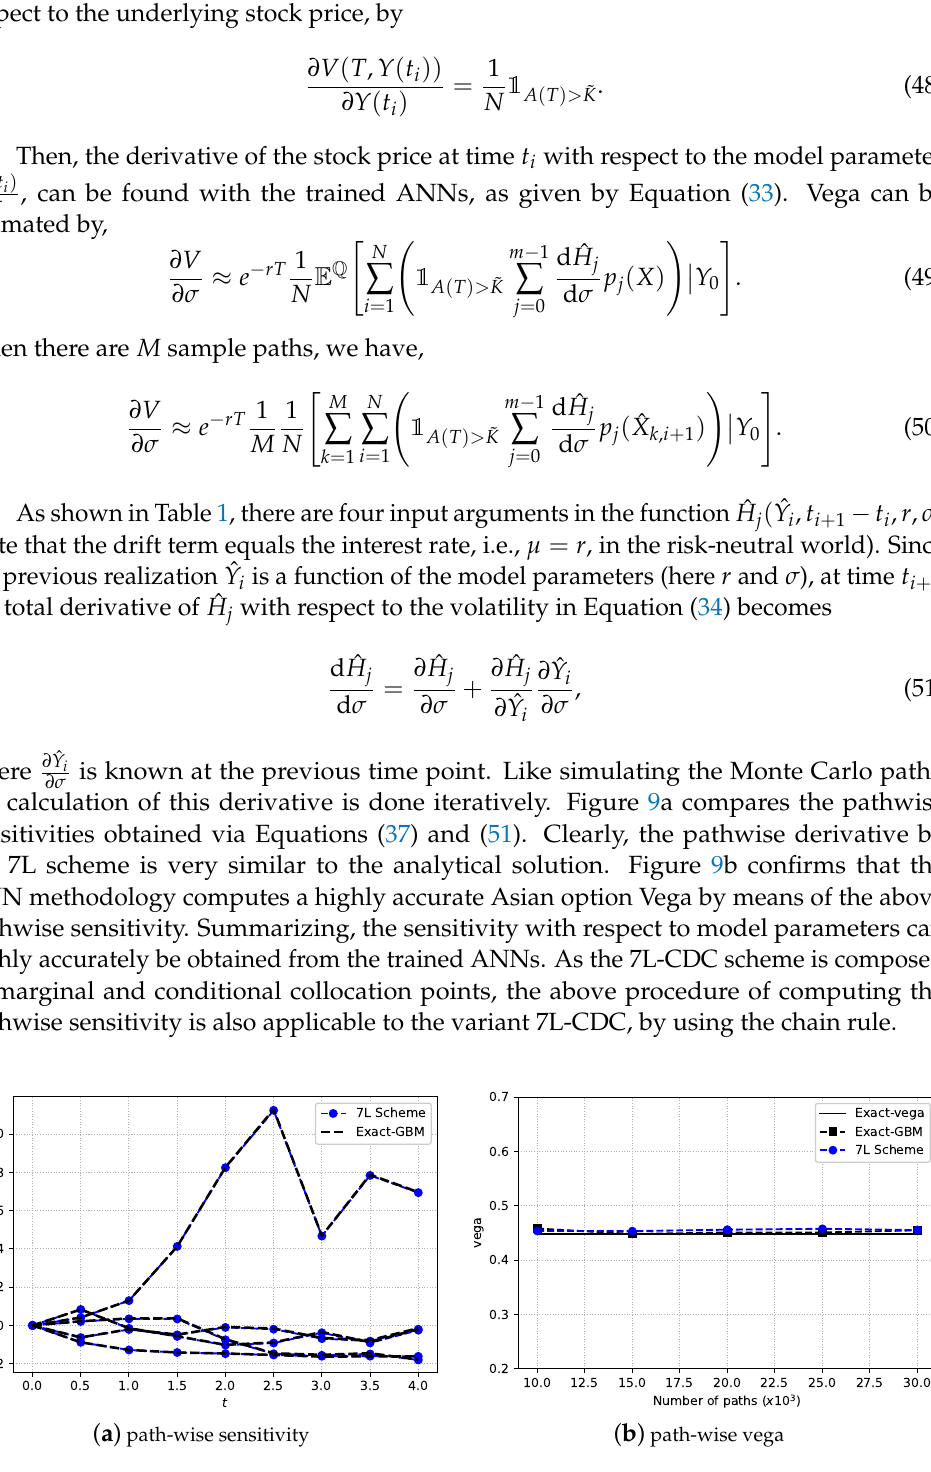
Figure 9. Path-wise estimator of Vega: Exact Vega is calculated by means of the central finite difference. The parameters are Y 0 = 1.0, r = 0.05, ˜ K = Y 0 , σ = 0.3, ∆ t = 1.0, N b = 4, T = ∆ t × N b =